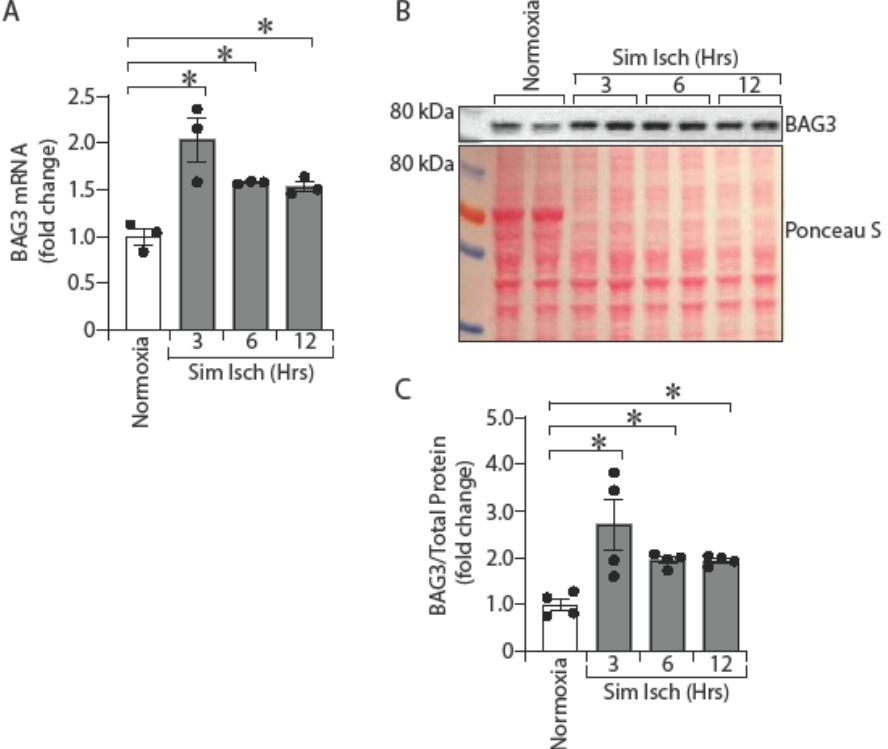
NCD-fed mice compared to the HFD-fed mice (Figure 2A,B; NCD vs. HFD, 1.0 ± 0.12 vs. 0.94 ± 0.15; p -value = 0.75). In contrast, ischemic HFD mice GA muscles expressed less BAG3 protein (Figure 2C,D; NCD vs. HFD, 1.0 ± 0.15 vs. 0.18 ± 0.04; * p < 0.05) and mRNA (Figure 2E; NCD vs. HFD, 1.0 ± 0.15 vs. 0.17 ± 0.04; * p < 0.05) than control GAs from NCD fed mice. Thus, in non-ischemic skeletal muscles, BAG3 expression is similar between non-diabetic NCD-fed mice and diabetic HFD-fed mice. However, in ischemic skeletal muscles, BAG3 mRNA and protein expression are significantly reduced in the HFD-fed mice compared to levels in the NCD-fed mice. These results suggest poor BAG3 expression in ischemic skeletal muscles in diabetes may play a role in the severity of limb injury in diabetic PAD.